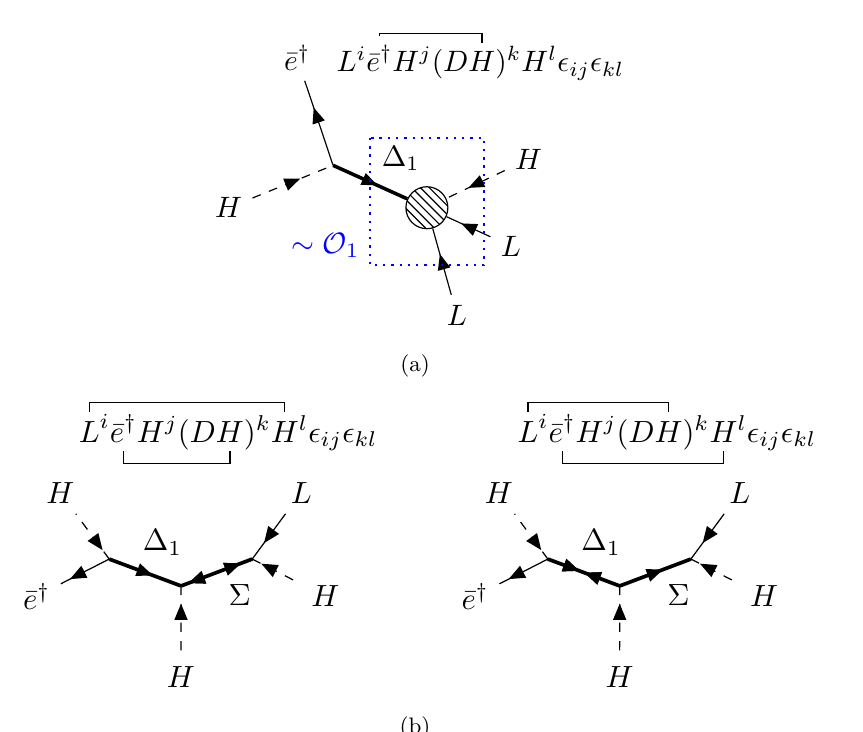
Figure 5. (a) An intermediate topology representing the operator O D 3 with all heavy fields except ∆ 1 integrated out. The contraction ¯ e † H ∼ ∆ † 1 gives rise to an effective operator similar to the Weinberg operator O 1 , shown in blue. This branch of the completion tree therefore involves models featuring ∆ 1 along with one of the seesaw fields. (b) The model with field content { Σ , ∆ 1 + ¯∆ † } arises from two similar diagrams, shown here. These correspond to the two ways the arrow-preserving and arrow-violating fermion propagators can be placed in the graphs for this furnishing of the